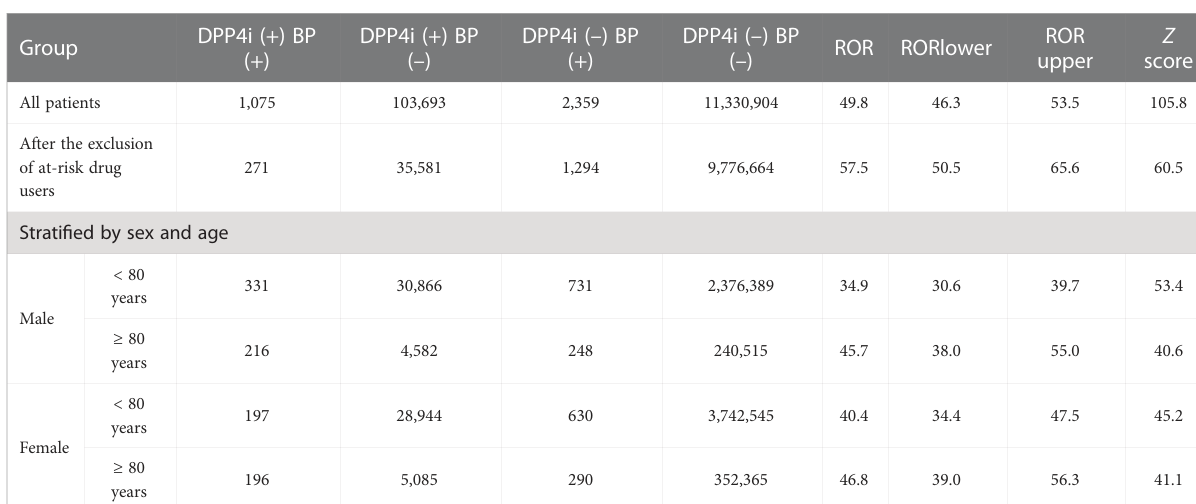
TABLE 2 Relationship between the emergence of bullous pemphigoid (BP) and the prescription of DPP4 inhibitors (DPP4i) based on FAERS data. (+); patients receiving DPP4 inhibitors or exhibiting BP; ( – ); patients not receiving DPP4 inhibitors or not exhibiting BP.